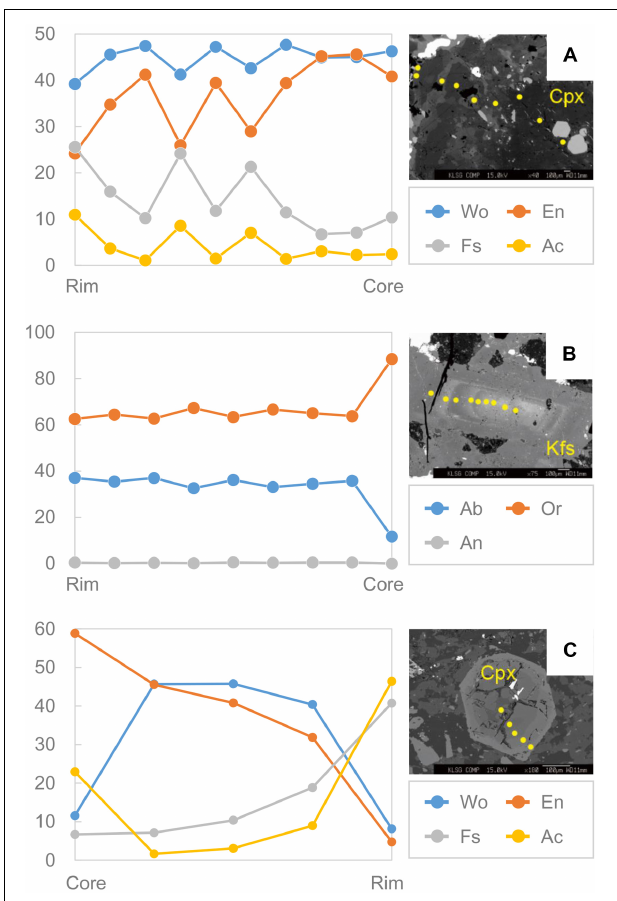
FIGURE 12 | Compositional profiles of zoned minerals. (A) A giant clinopyroxene crystal in the clinopyroxenite; (B) K-feldspar in the samples collected from the center of syenite; (C) A clinopyroxene ( Figure 7E ) in the late-stage syenite dyke.